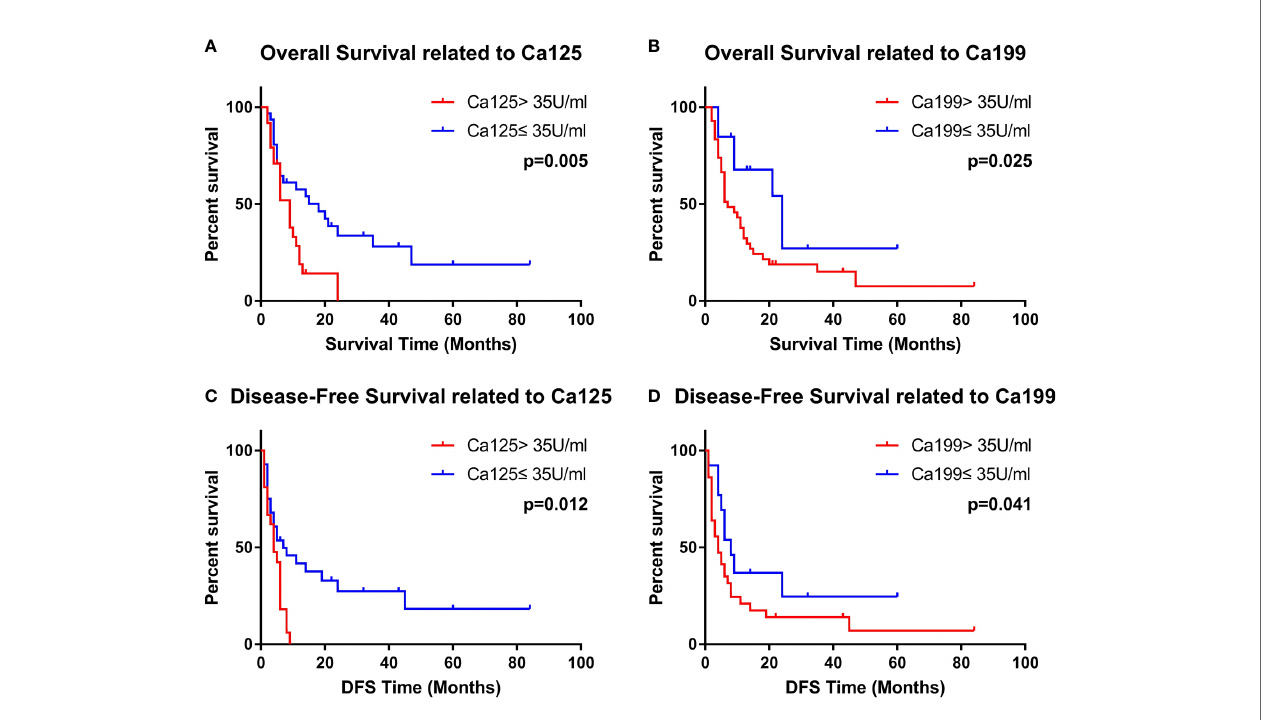
FIGURE 1 | The Relationship between serum level of Ca199 and Ca125 and the OS/PFS of PASC